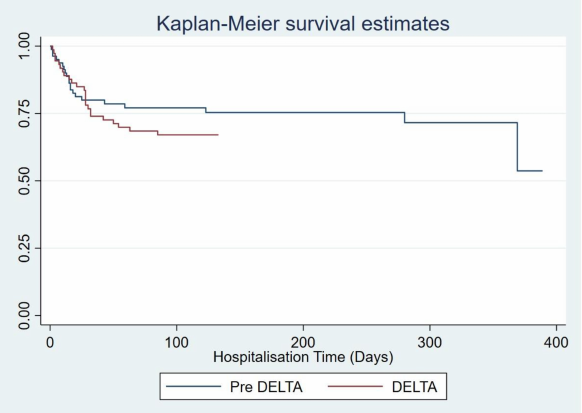
Figure 1. Kaplan–Meier curve depicting the survival of the pre-delta and delta